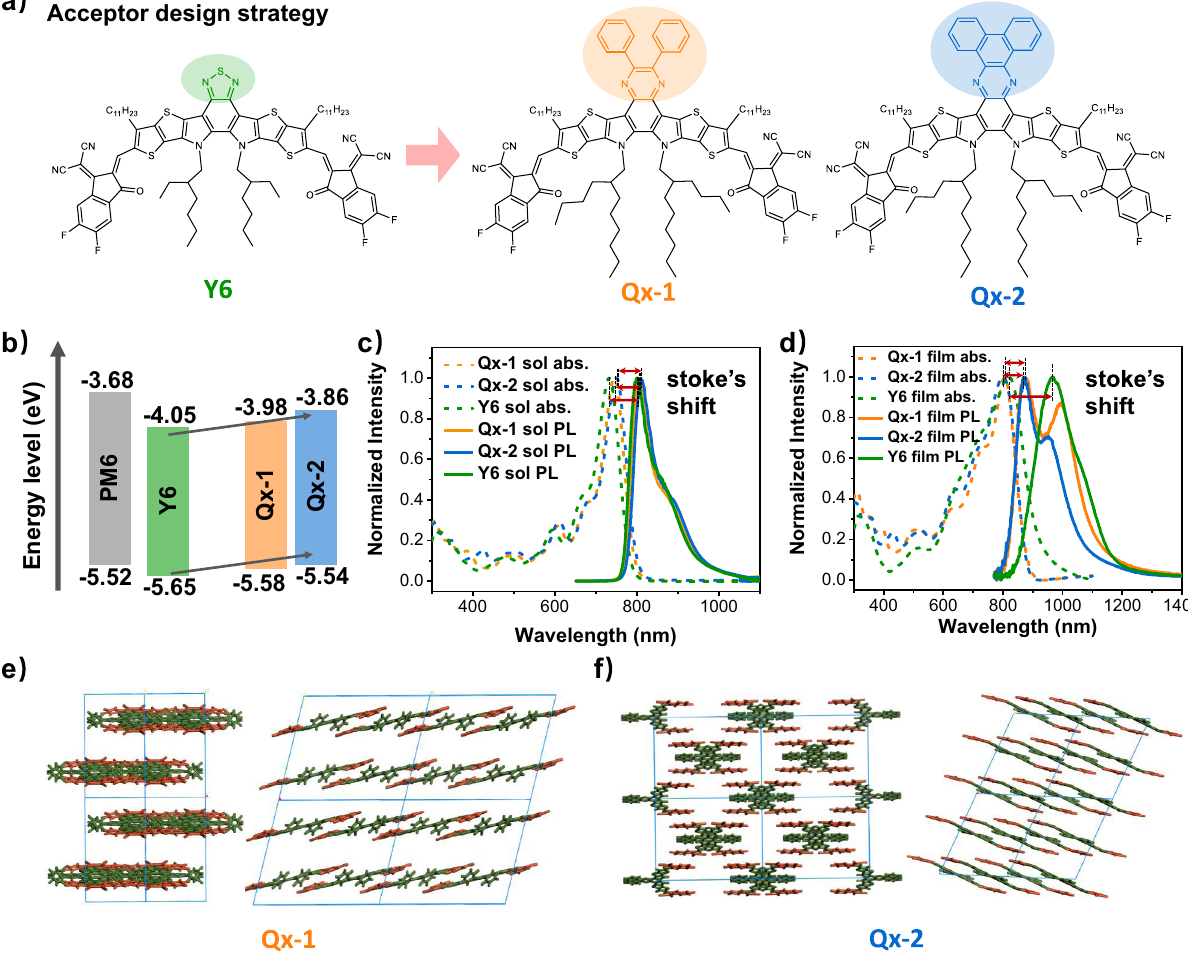
Fig. 1 Molecular design and optoelectronic characterization of Qx-1 and Qx-2. a Chemical structures of Y6, Qx-1 and Qx-2 acceptors. b Energy level diagram of the related materials. c UV – vis absorption (abs.) and photoluminescence (PL) spectra of acceptors in the solution. d UV – vis absorption (abs.) and photoluminescence (PL) spectra of acceptors in the fi lms. e , f The molecular packing patterns of Qx-1 and Qx-2 in the single-crystal